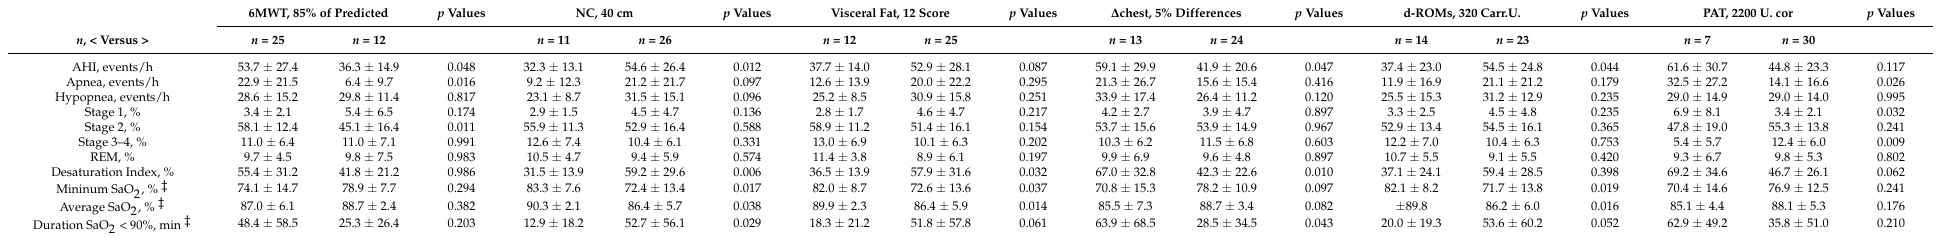
Table 2. Comparisons between polysomnography-derived variables per subgroup. Data are presented as mean ± standard